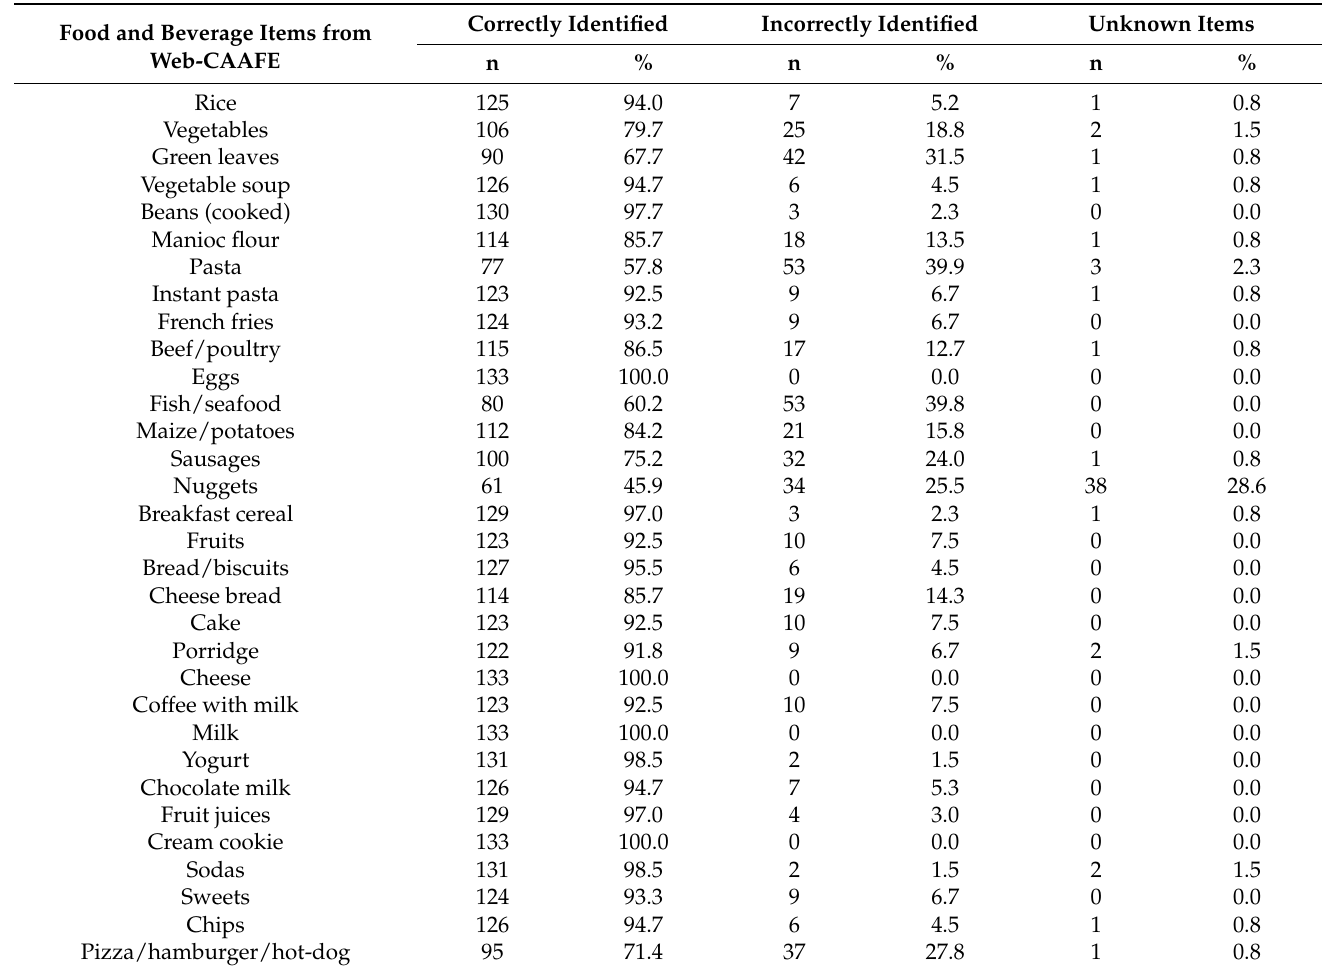
Table 3. Frequencies of identification of 32 food and beverage items from Web-CAAFE by 7–10-year- old schoolchildren, Florian ó polis, Southern Brazil,